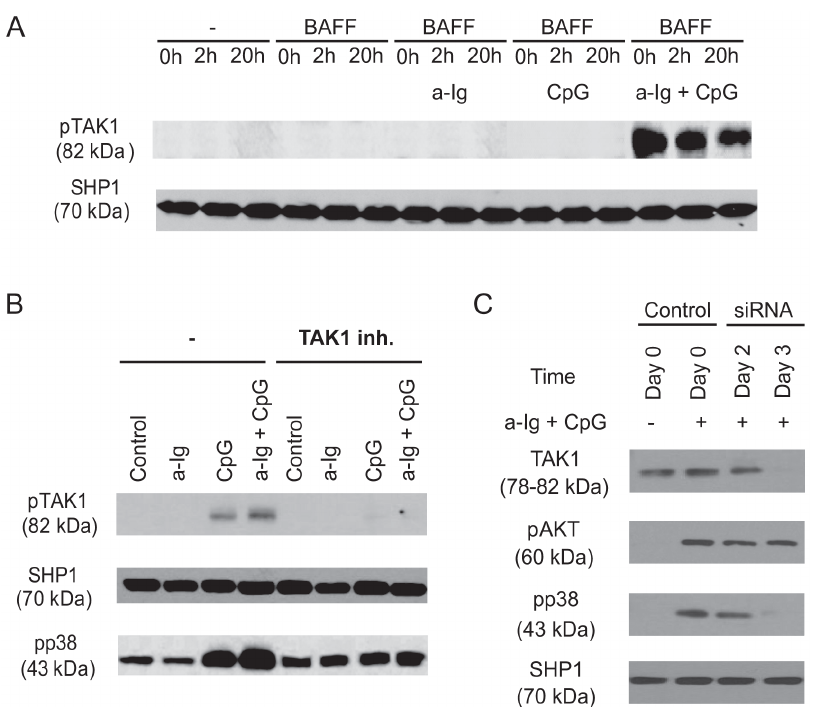
Figure 2. BCR and TLR9 induced signals synergistically activate TAK1 and p38 MAPK in human B cells that is independent of BAFF. (A) Purified human B cells were left untreated (0 h) or pretreated with 100 ng/ml BAFF for 2 h or 20 h, and then in the last 30 min of pretreatment were activated with anti-Ig (2.5 m g/ml) and/or CpG (1 m g/ml), (B) B cells were stimulated with anti-Ig (2.5 m g/ml), CpG-ODN (2 m g/ml) or the combination of both reagents as indicated for 30 min, in the absence (-) or presence of specific TAK1 inhibitor, (5Z)-7-Oxozeaenol, then samples were subjected to Western blot analysis using pTAK1 or pp38 MAPK specific antibodies. C) Control and TAK1-specific siRNA transfected BJAB cells were activated with 2.5 m g/ml anti-Ig and 1 m g/ml CpG for 30 minutes, and subjected to Western blot analysis to measure TAK1, pAKT and pp38 level. SHP1 was used as a loading control.